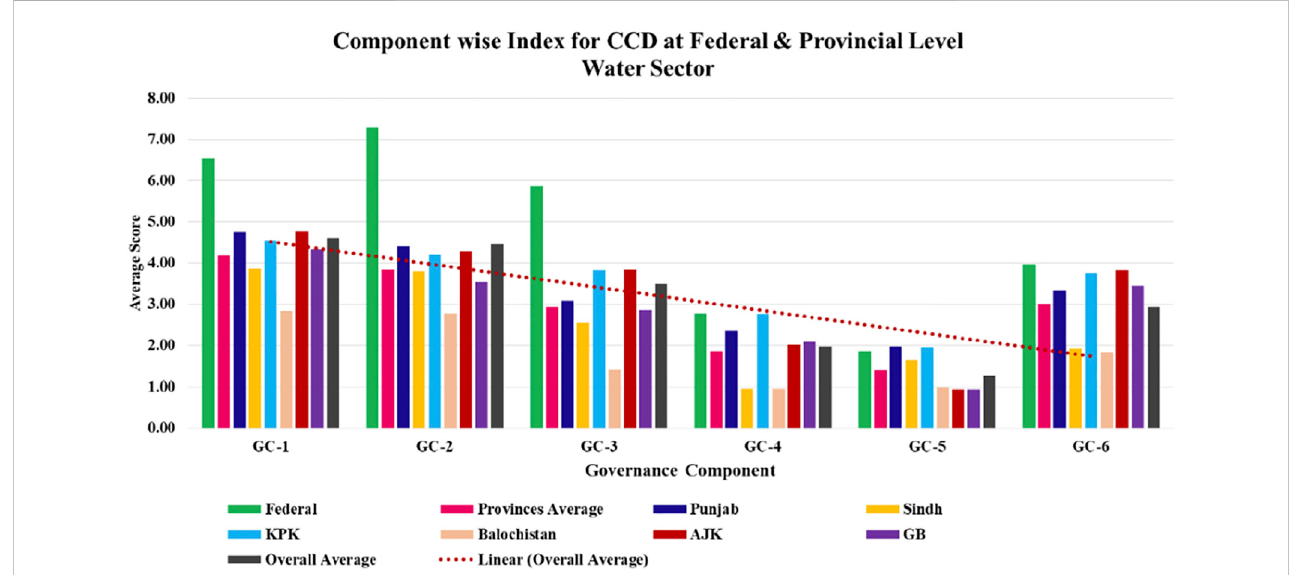
FIGURE 4 Index showing state of water sector governance at different constituencies.